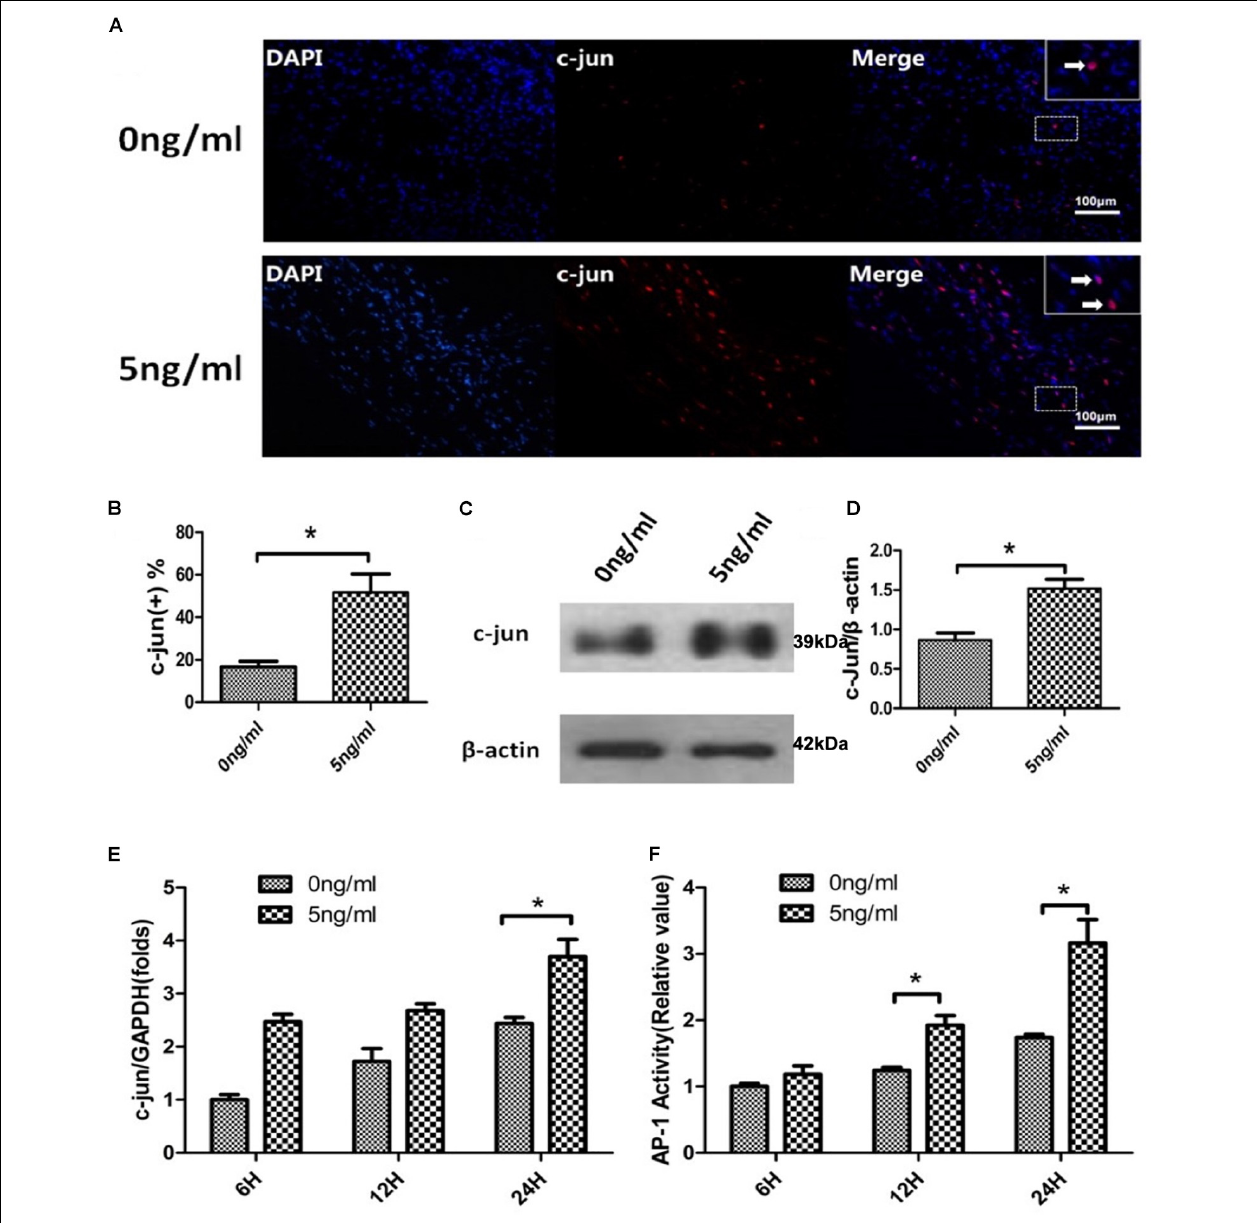
FIGURE 4 | c-JUN and AP-1 activity assay in the in vitro WD model. Immunofluorescent staining of c-JUN (A, arrows indicate c-JUN(+) cells ) , analysis of percentage of endonuclear c-JUN(+) cells (B), and western blotting to quantitatively analyze expression of c-JUN (C,D) in SCs with or without 5 ng/ml IL-1 β at 24 h. qPCR